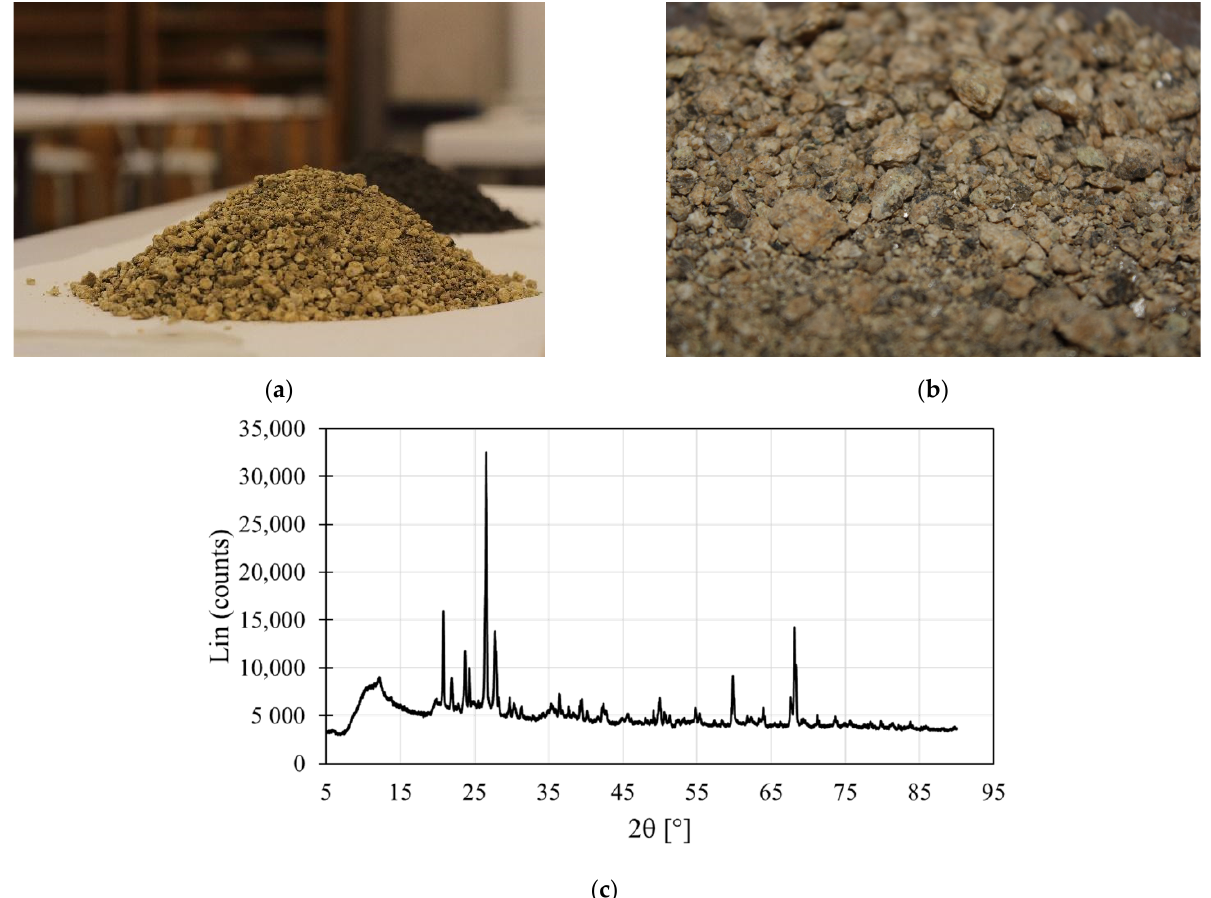
Figure 7. Maicillo from Quilpué city: ( a ) laboratory scale; ( b ) detailed view of Maicillo; ( c ) XRD analysis on Maicillo (R wp = 6.4 GoF = 4.4). Table 2. Characterization of